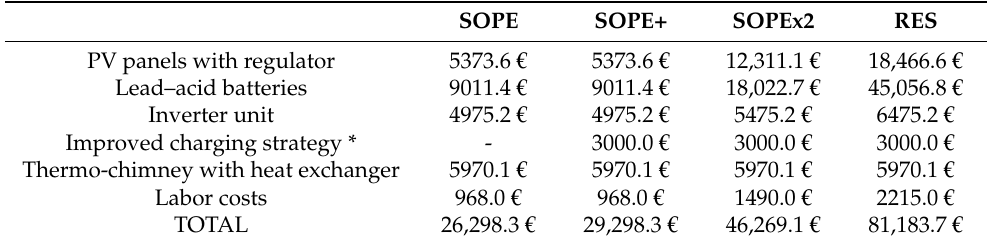
Table 9. Investment costs in all the modelled configurations according to the SOPE investment costs and the size of the modelled configurations [38]. SOPE SOPE+ SOPEx2 RES PV panels with regulator 5373.6 € 5373.6 € 12,311.1 € 18,466.6 € 9011.4